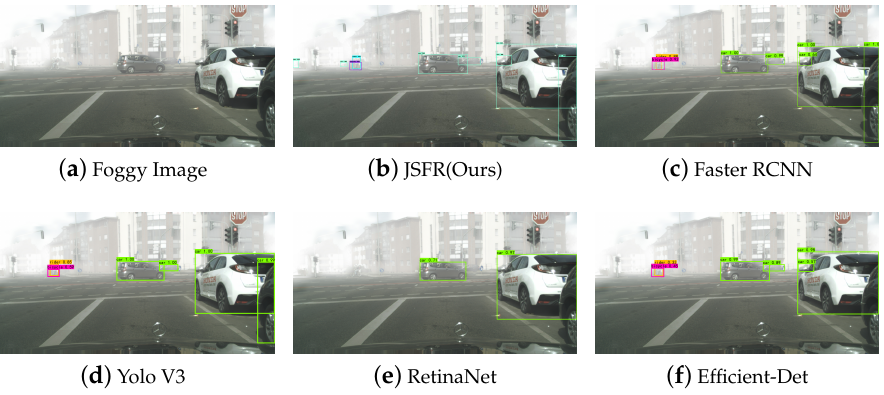
Figure 6. Test results of JSFU and object detection methods including Faster RCNN , Yolo V3 , RetinaNet and Efficient-Det on Foggy Cityscapes with sparse fog (electronic zoom-in recommended).